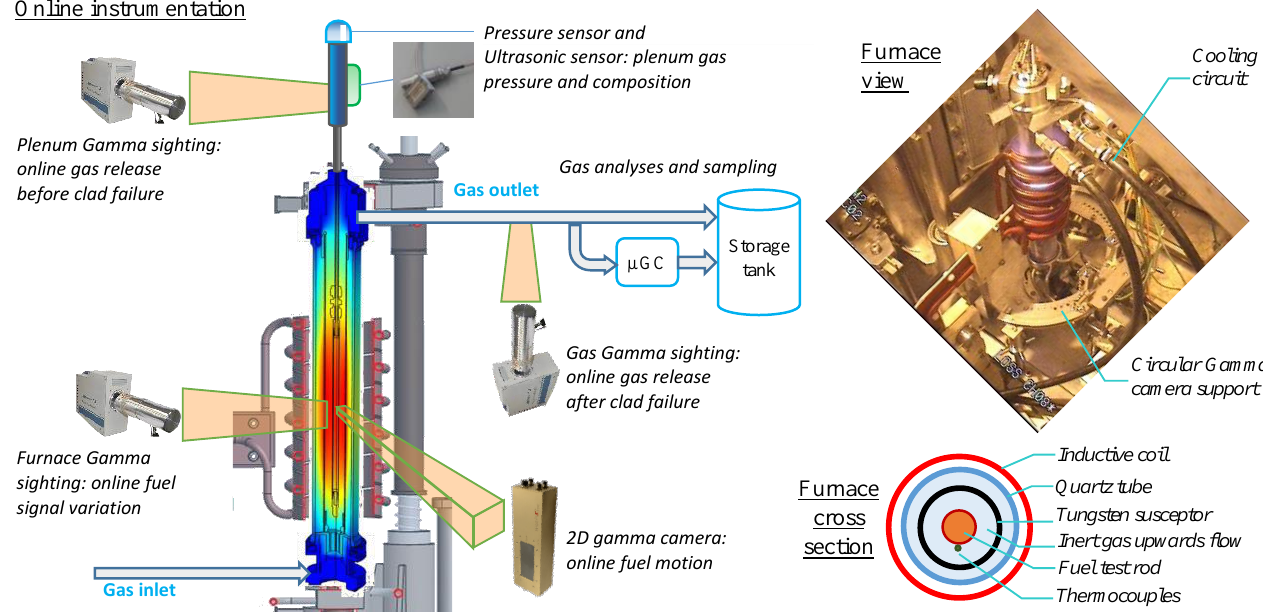
Fig. 2. VINON-LOCA online instrumentation, furnace view and furnace cross